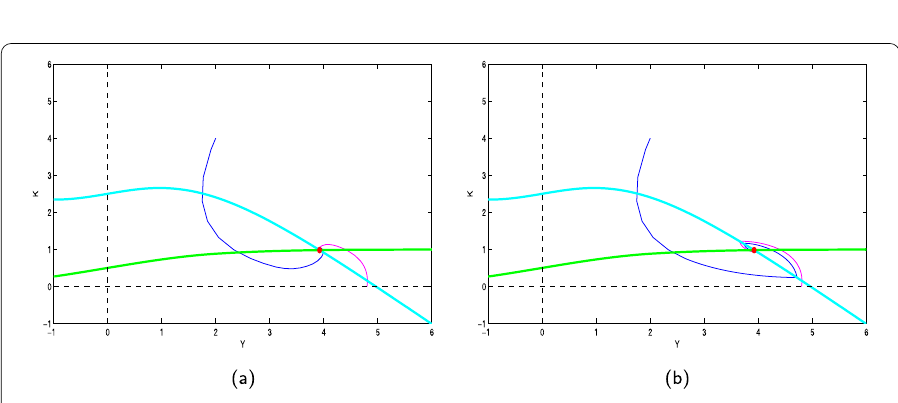
Figure 2 ( a ) τ 2 = 2.9, the positive equilibrium is asymptotically stable. ( b ) τ 2 = 21.7, the positive equilibrium is asymptotically stable